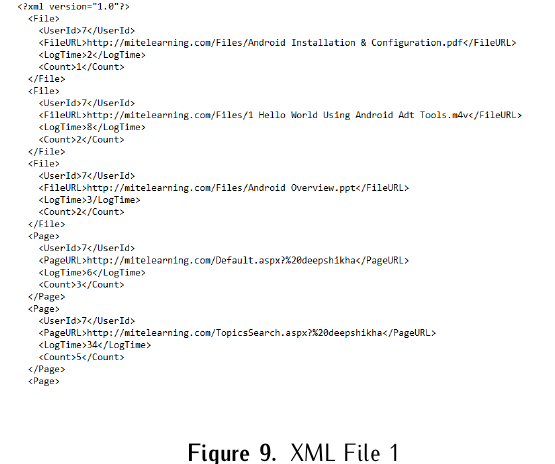
Figure 9. XML File 1